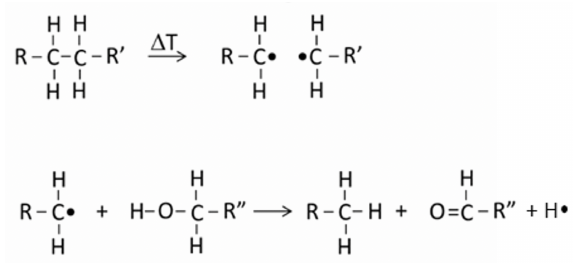
Figure 9. Proposed reaction mechanism between radicals produced during decomposition and alcohols in the oils, leading to the formation of